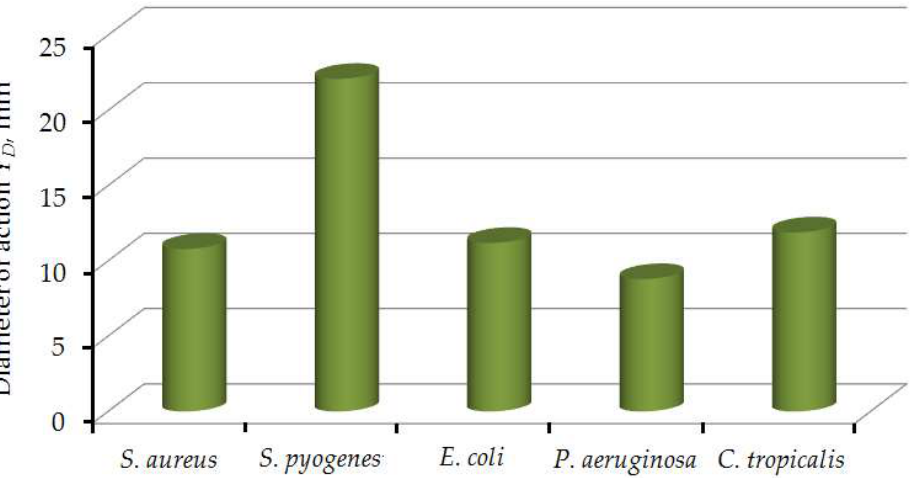
Figure 8. Diameter of the protective effect of biopolymer nanofilled films on the studied bacteria.!